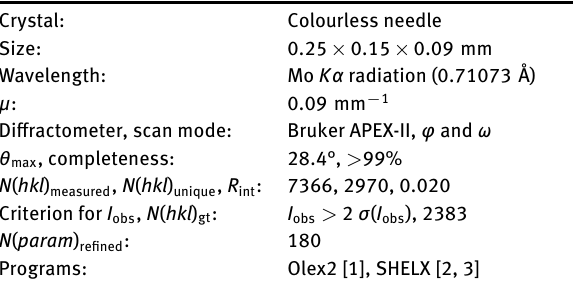
Table 1: Data collection and handling.